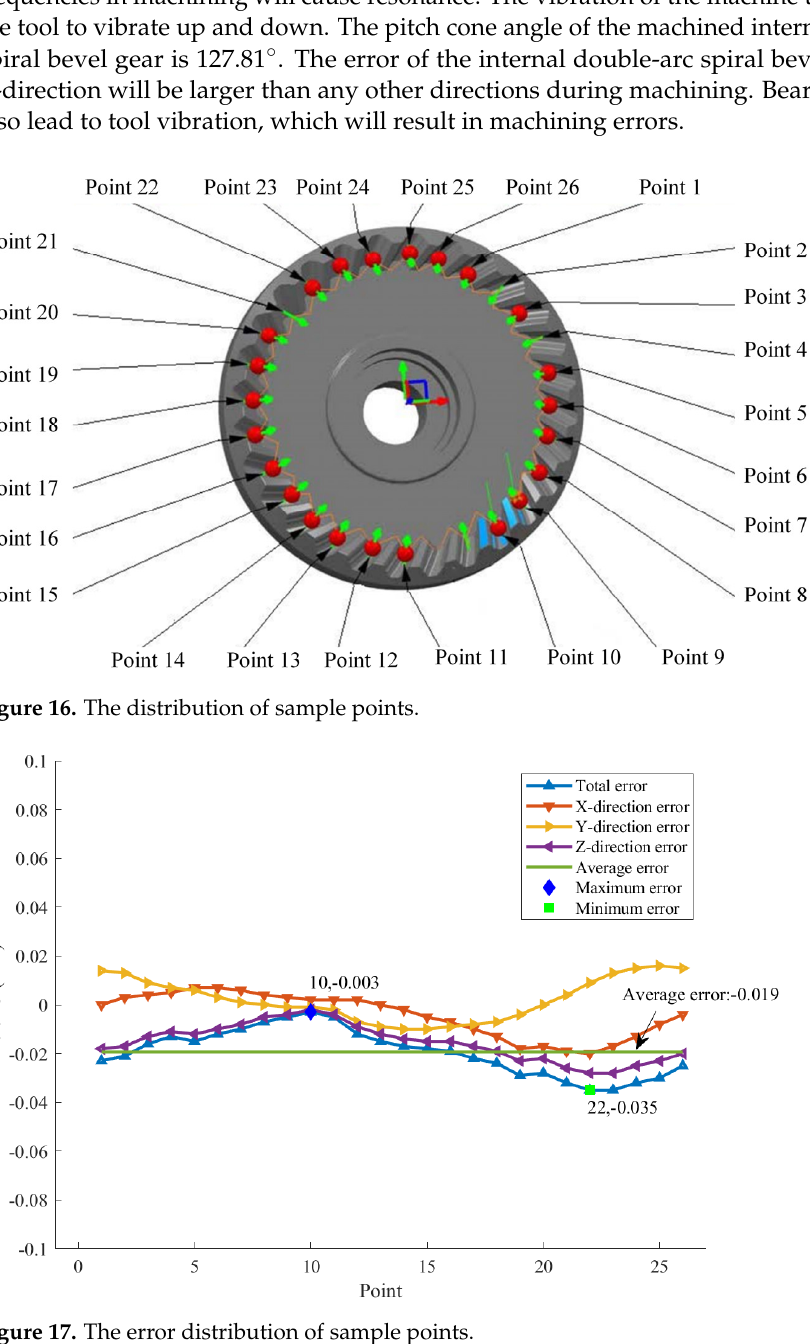
Figure 15. Actual machining process: ( a ) Fixing of the blank and tool setting; ( b ) Preliminary ma- chining with a flat bottom cutter; ( c ) Machining the convex tooth surface; ( d ) Machining the transi-